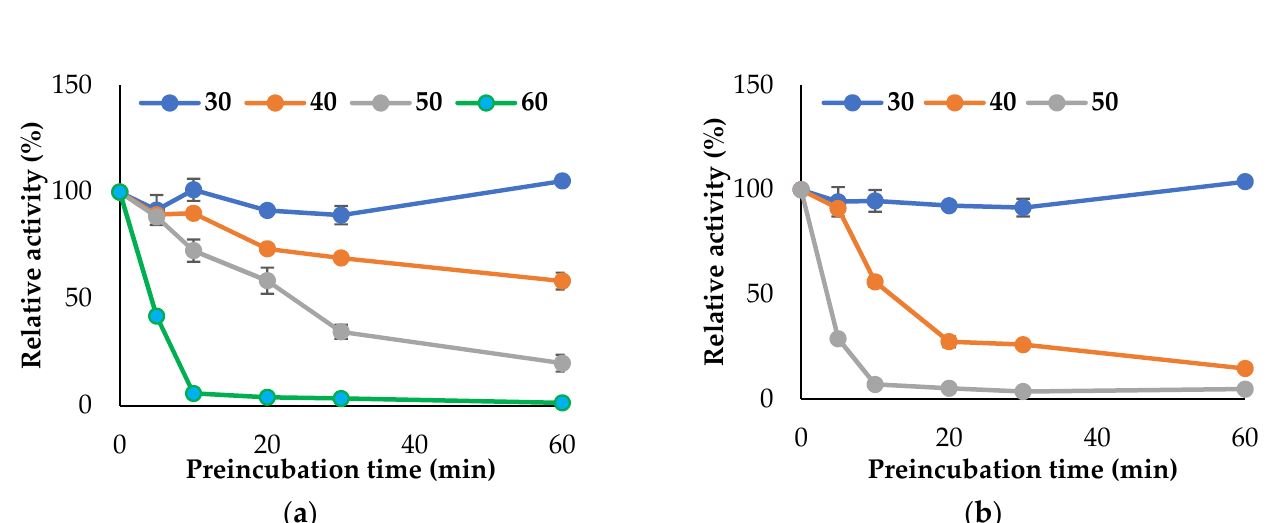
Figure 5. Optimum pH of Est2L ( a ) and Est4L ( b ). Enzyme activities were measured by a continuous method at each